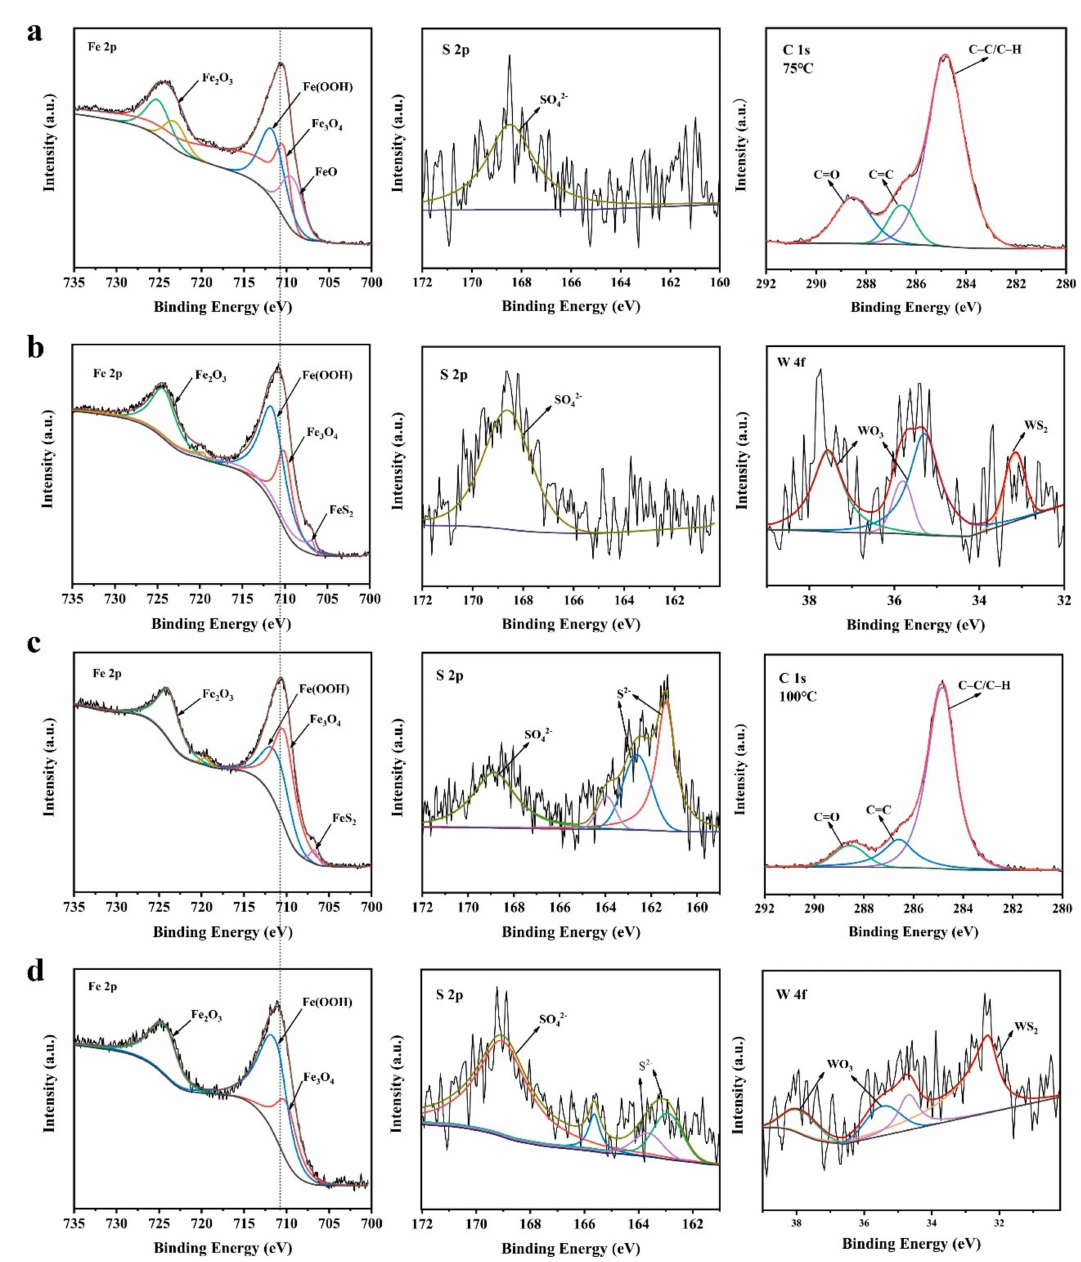
Figure 10. XPS spectra of the elements (C 1s, Fe 2p, S 2p and W 4f) on the worn surfaces, lubricated by pristine PAO6